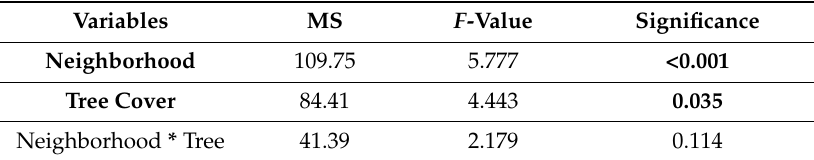
Table 8. Two-way ANOVA for mean heat index at 1500 LDT for the entire warm season based on neighborhood classification and tree density, including mean-square error (MS), F value, and significance. Bold variables are significant ( p <